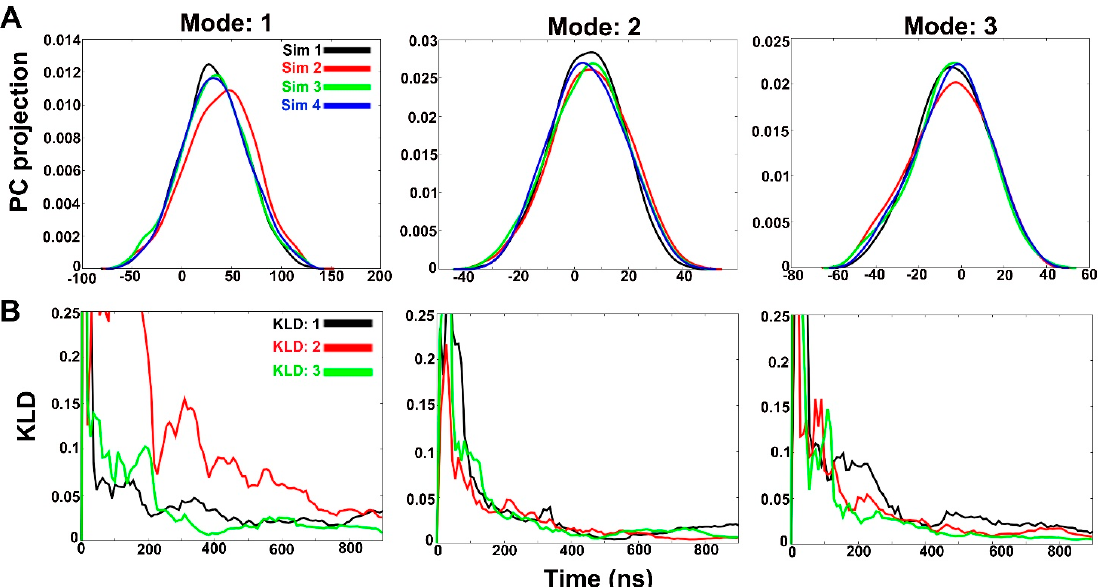
Figure 3. ( A ) Histograms of projection of principal components 1, 2 and 3 for all four simulations in water. Histograms were calculated using a Gaussian kernel density estimator. ( B ) A measure of overlap between histograms from independent simulations calculated using Kullback-Leibler divergence method. The slope values lying below 0.025 indicate convergence between two independent runs.